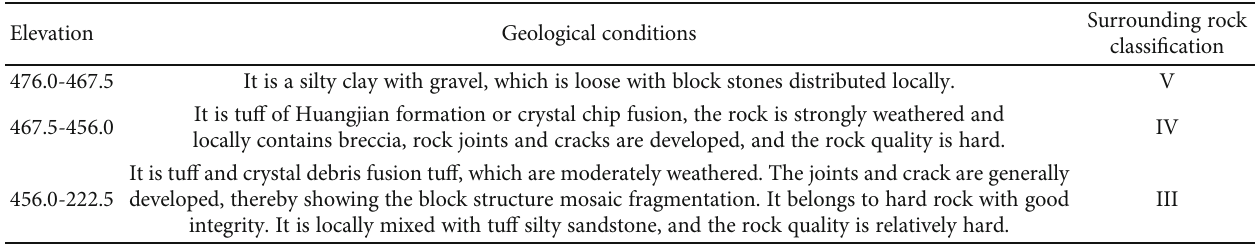
Table 3: Geological conditions of the shaft in Jinhua mountain tunnel.